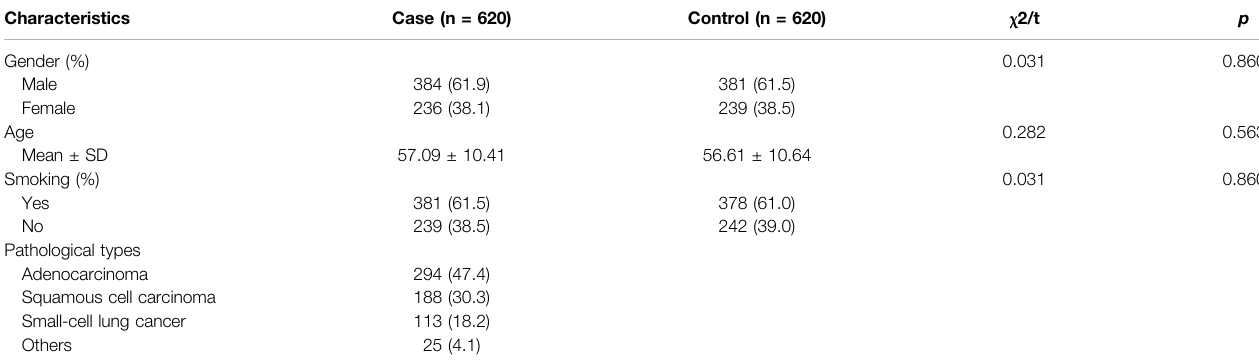
TABLE 1 | Basic information of the participants. Characteristics